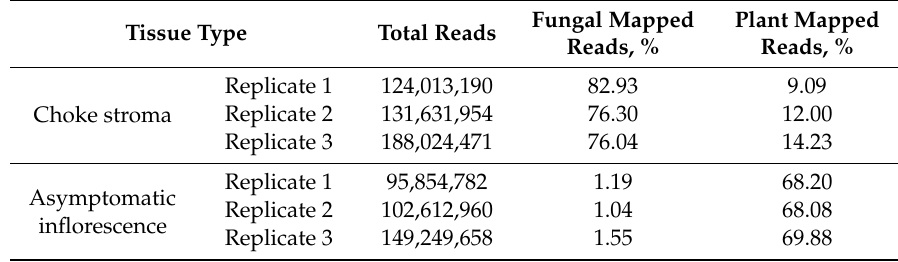
Table 2. RNA-seq mapping